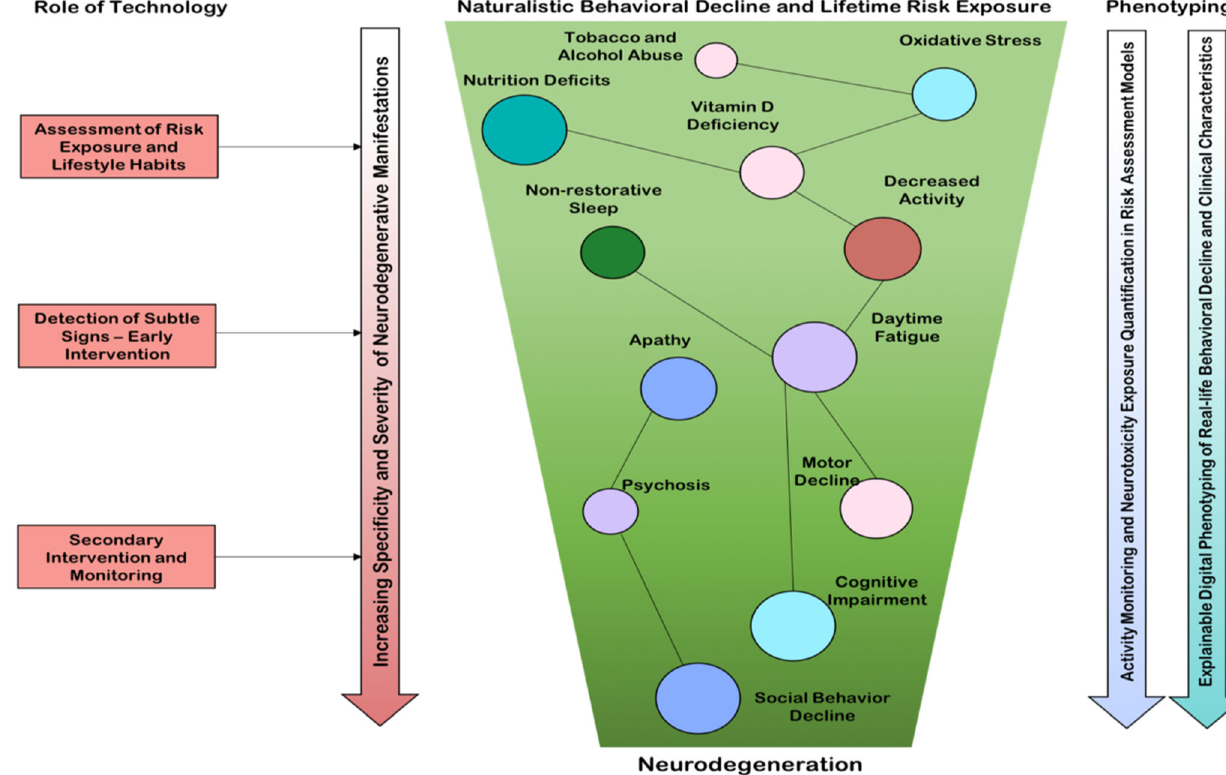
Fig. 4 The causality model of real-life neurotoxicity exposure and neurodegenerative manifestations. An ideal risk assessment model starts in early adulthood, where speci fi c lifestyle behaviors predisposes the brain to neurodegeneration, but without developing symptoms. With aging, when disease tolerance starts declining, neurodegenerative manifestations begin as subtle behavioral decline in-the-wild, affecting motor, cognitive, and emotional domains. The role of digital technology in characterizing the phenotype can be viewed as (1) toxicity exposure and risk assessment and (2) explanations for the quantitative behavioral